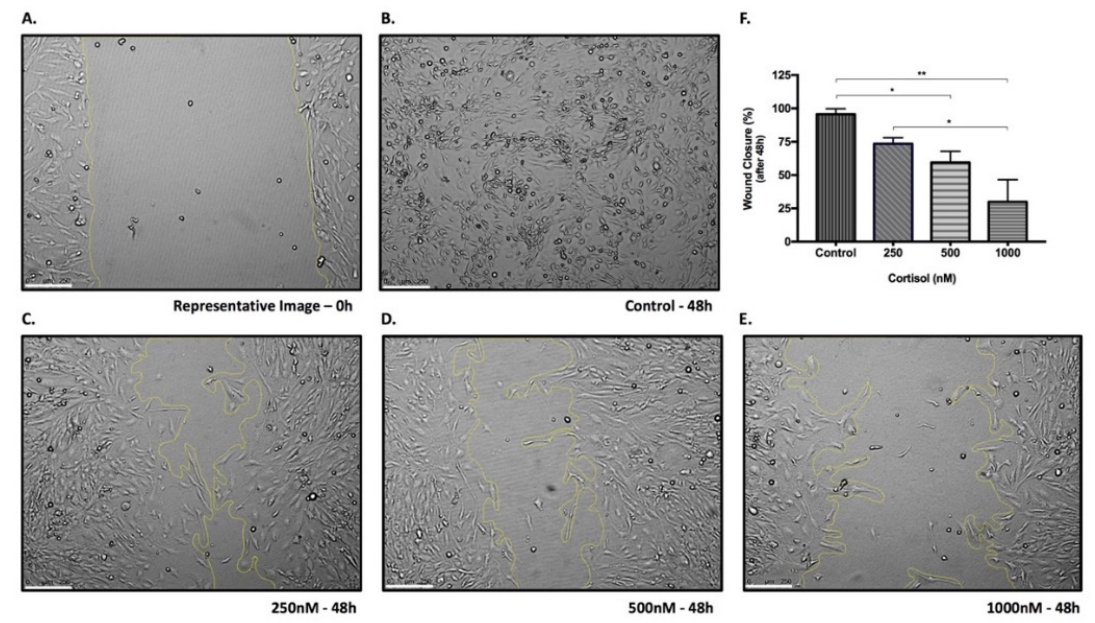
Figure 7. Wound healing assay. Representative image of 0 h time-point ( A ) and representative images after 48 h of SGHPL-4 cells stimulation: vehicle (control) ( B ), 250 nM ( C ), 500 nM ( D ) and 1000 nM ( E ) of cortisol. Quantification of wound closure (%) after 48 h of stimulation ( F ). Data were compared by one-way ANOVA with Tukey multiple comparisons test. Data are presented as mean ± SEM. * p < 0.05, ** p < 0.01. Cell treatment was repeated three times. Scale bar = 250µm.